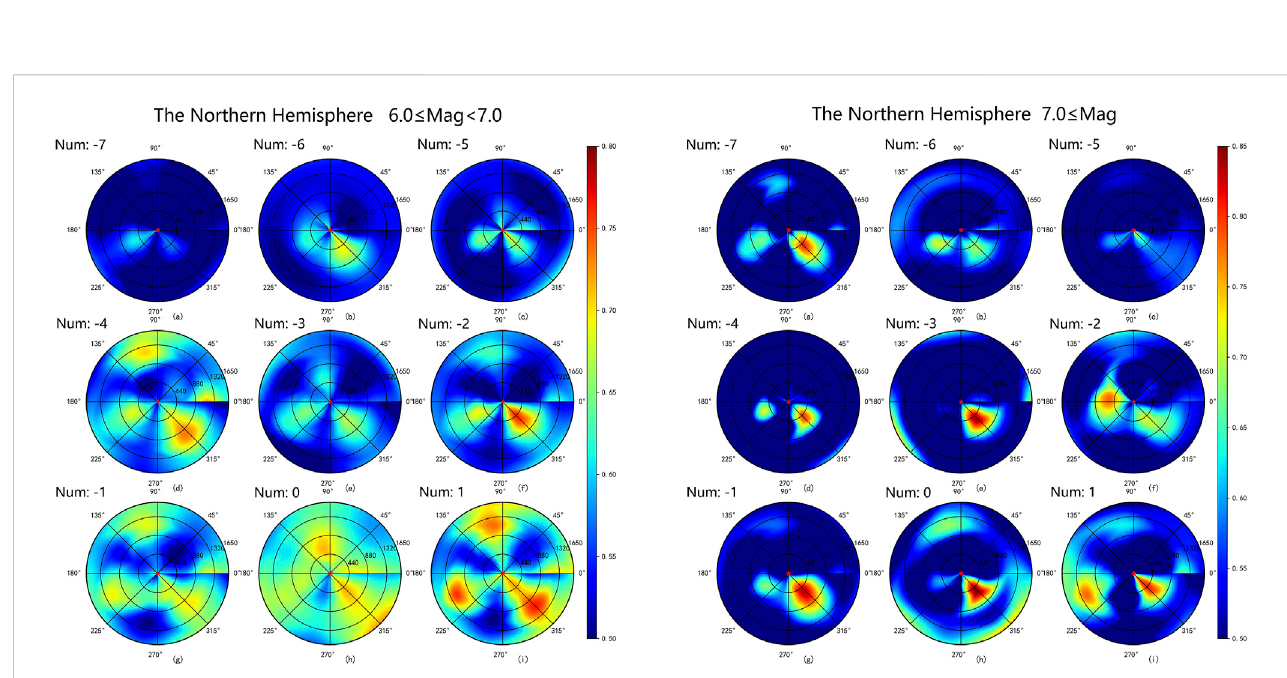
Spatial and temporal distribution of spatial electric fi eld ELF band disturbances for earthquakes of magnitude 6.0 – 7.0 and magnitude 7+ in the Northern Hemisphere.(Num: − 7toNum: − 1representstheseventhcycletothe fi rstcyclebeforetheearthquake,Num:0istheperiodofearthquake,Num:0isthe fi rst period after the